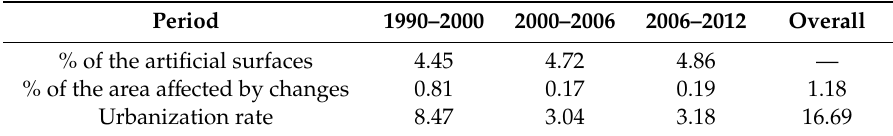
Indicators of the land cover / land use (LCLU) changes a ff ecting the Romanian CA during 1990–2012.